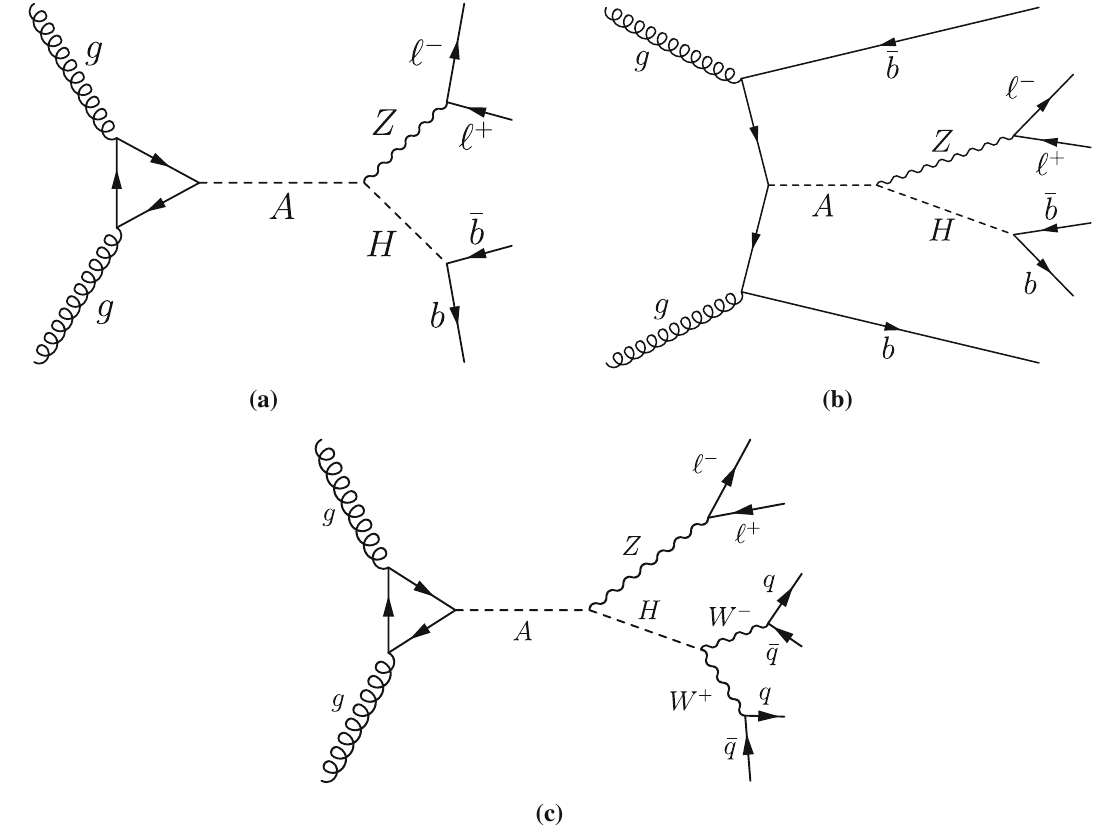
Fig. 1 Example lowest-order Feynman diagrams for a gluon–gluon fusion production of A bosons decaying into Z H → (cid:6)(cid:6) bb , b b -associated production of A bosons decaying into Z H → (cid:6)(cid:6) bb , and c gluon–gluon fusion production of A boson decaying into Z H → (cid:6)(cid:6)